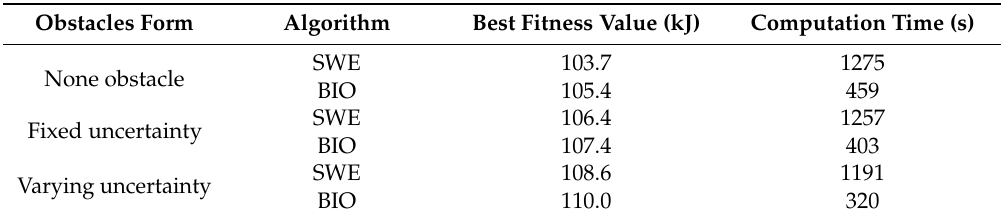
Table 1. Performance comparison of bilevel optimization (BIO) and sliding wavefront expansion (SWE) with different